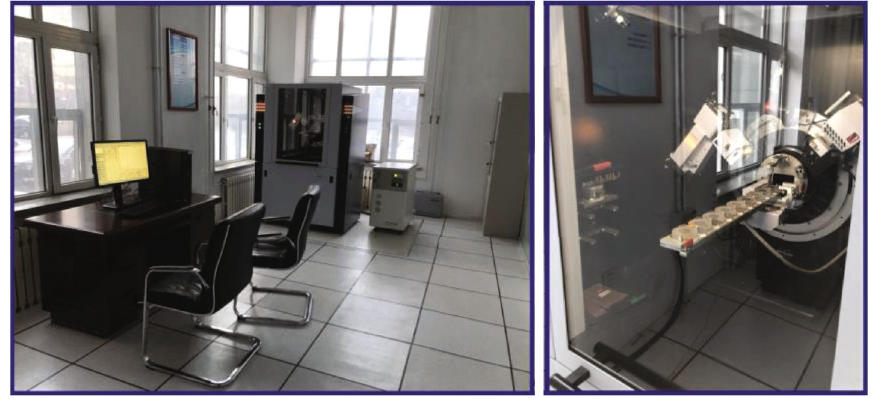
Figure 8: D8-ADVANCE X-ray di ff ractometer.